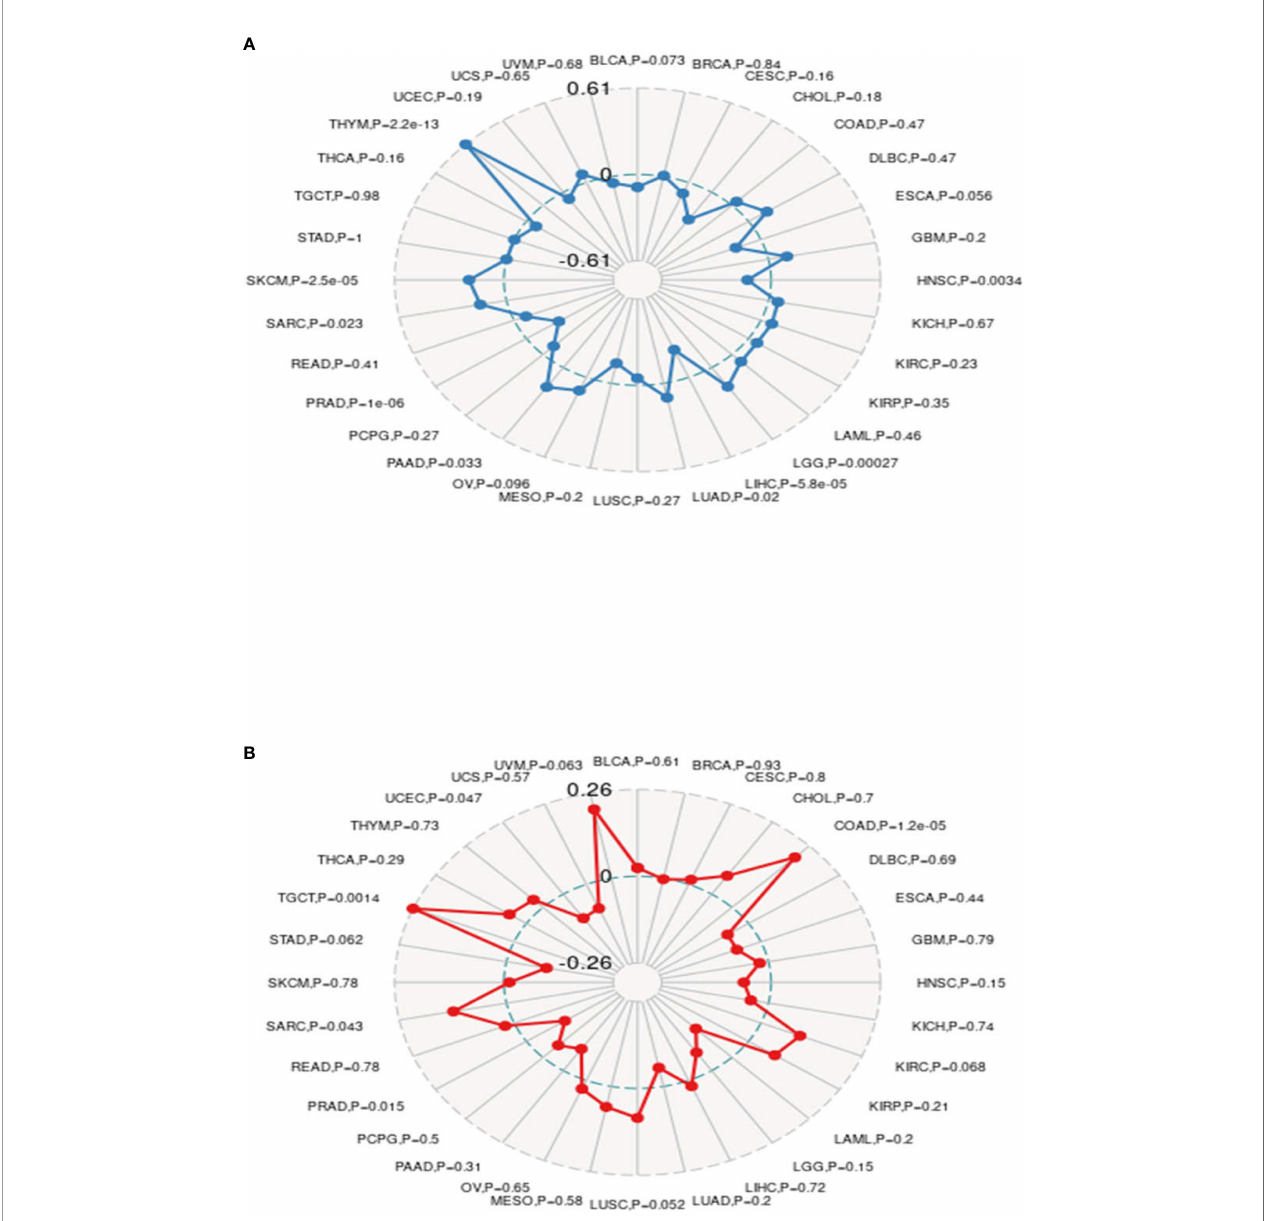
FIGURE 12 | The expression of matrix metalloproteinase 14 (MMP14) was correlated with tumor mutational burden (TMB) and microsatellite instability (MSI). (A) Radar images were used to show the correlation between MMP14 expression and TMB. The black value represents the range, and the blue curve represents the correlation coef fi cient. (B) Radar images were used to show the correlation between MMP14 expression and MSI. The black value represents the range, and the red curve represents the correlation coef fi